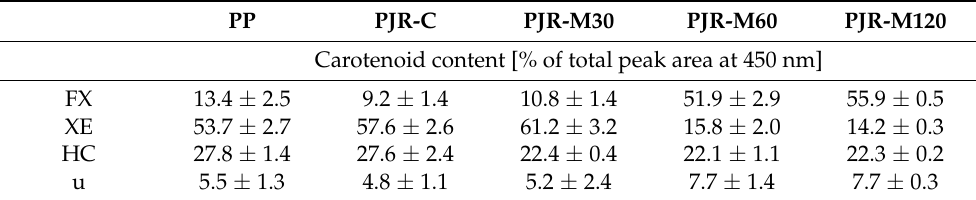
Table 3. Relative content of free xanthophylls (FXs), xanthophyll esters (XEs), and hydrocarbon carotenoids (HCs) as well as unidentified carotenoids (U) in untreated persimmon pulp (PP) and persimmon juice residues (PJR) obtained from juice production process without (PJR-C) or with pulp treatment at different microwave heating conditions (PJR-M30, PJR-M60, and PJR-M120). PP PJR-C PJR-M30 PJR-M60 PJR-M120 Carotenoid content [% of total peak area at 450